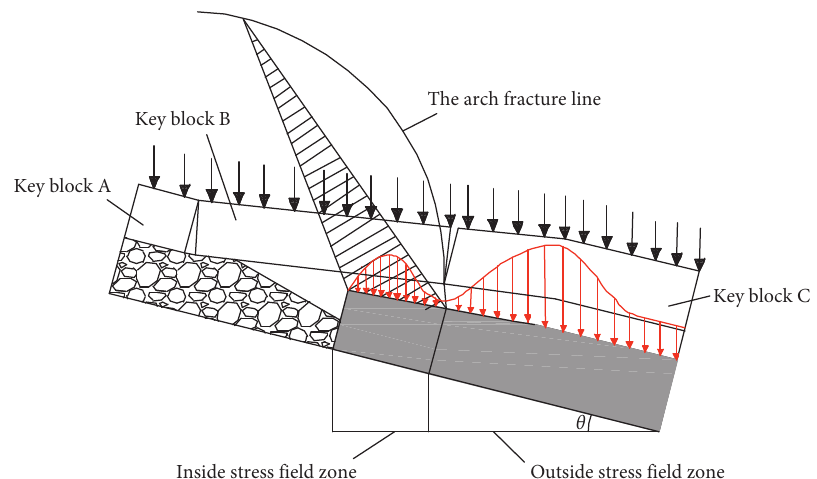
Figure 2: Lateral abutment stress distribution along dip direction in coal mass adjacent to gob.